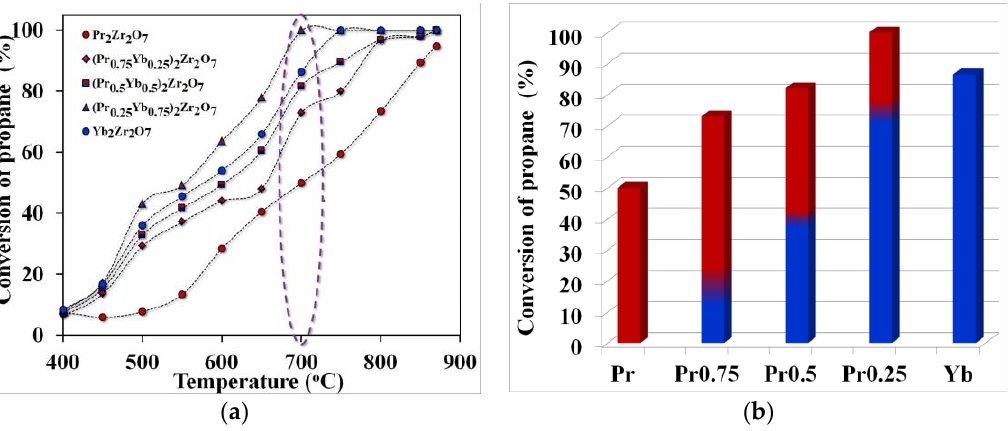
Figure 4. Temperature dependence of propane conversion (purple highlights the temperature of optimal technological conditions)—( a ), propane conversion rates at the optimum cracking temperature—( b ).